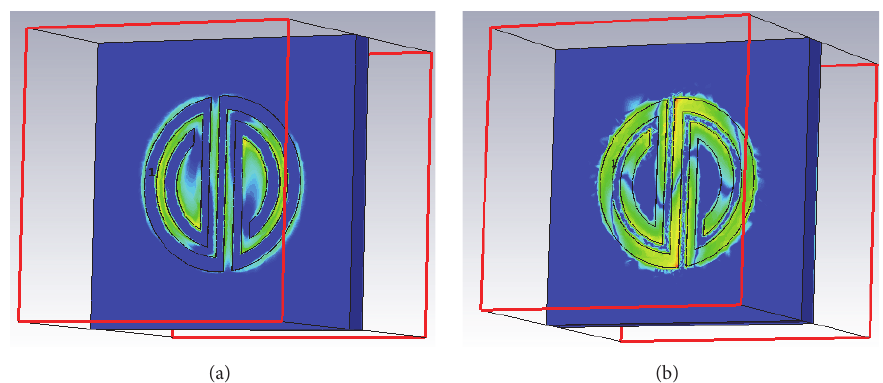
Figure 4: (a) Magnetic field and (b) electric field distributions for the proposed unit cell at 10.75 GHz.